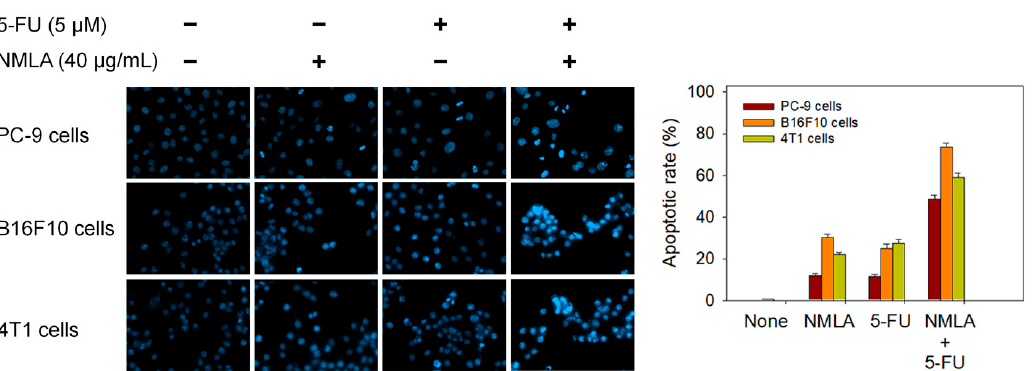
Figure 6. The co-cytotoxic effect of the clinical anticancer drug 5-FU with N. miranda -leaf-acetone. N. miranda -leaf-acetone (NMLA; 40 μ g/mL) and 5-FU (5 μ M) were used to investigate the cytotoxic effect on PC-9, B16F10, and 4T1 cells apoptosis. The collective data suggested potential synergistic anticancer effect when co-treatment.